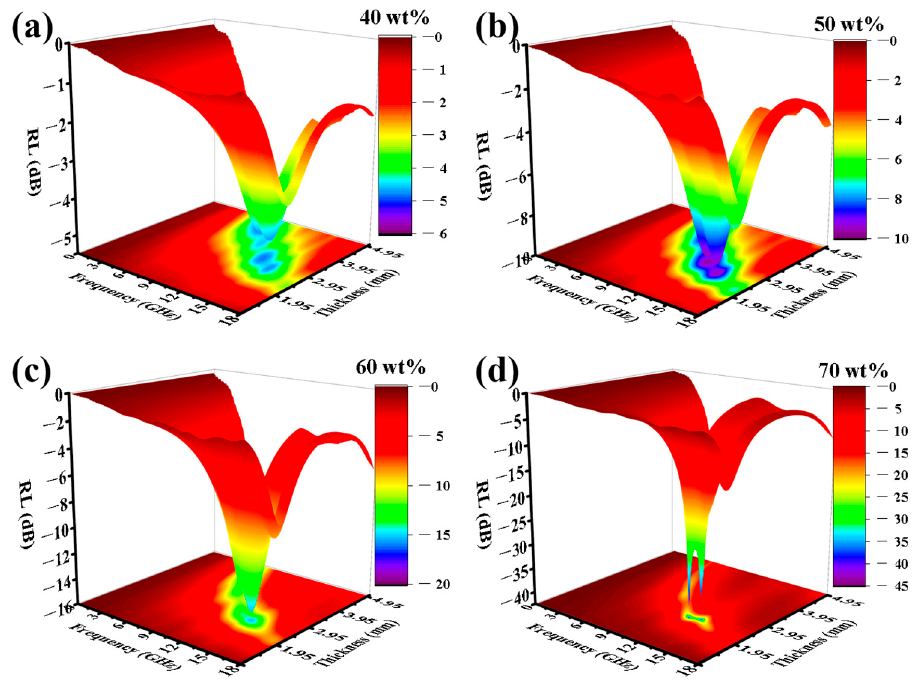
Figure 8. The RL vs. frequency diagram with ( a ) 40 wt%, ( b ) 50 wt%, ( c ) 60 wt%, and ( d ) 70 wt% FeNi 3 alloy filling ratios.